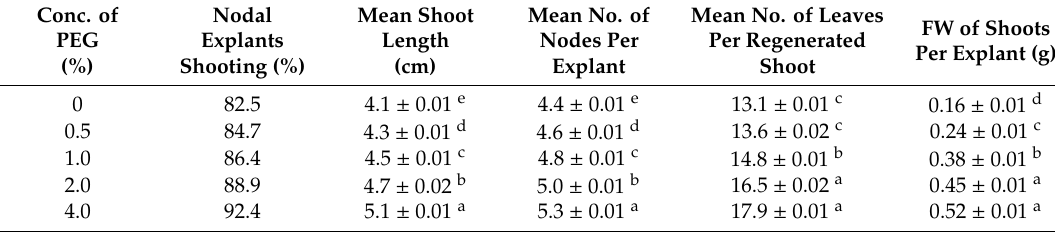
Table 1. Comparison of physiological parameters in 4-week-old shoots produced from nodal explants on Murashige and Skoog (MS) medium supplemented with different concentrations of PEG 6000. Conc. of